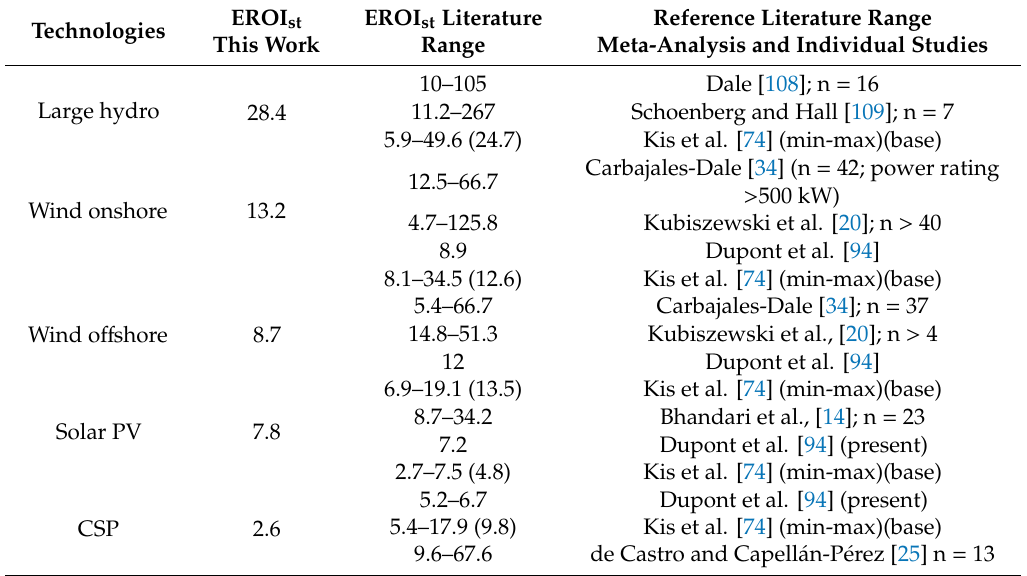
Table 4. Comparison of the EROIst obtained in this work with the literature. “n” represents the number of the studies reviewed in meta-analysis studies. EROIst levels are not